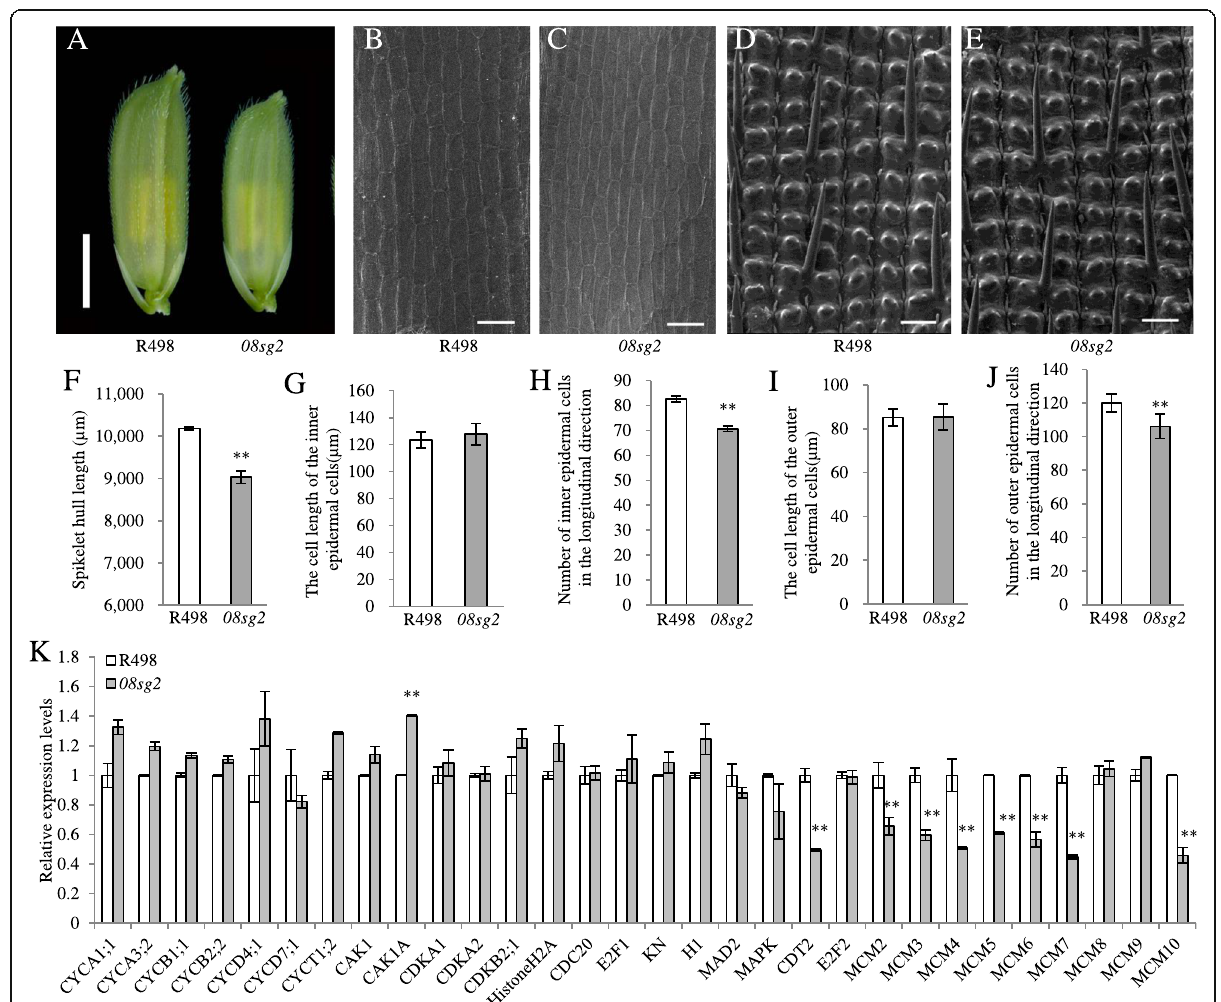
Fig. 2 08SG2 regulates grain length by changing cell division patterns. a The spikelet hulls of R498 and 08sg2 plants before anthesis. Scale bar, 3 mm. b , c Inner epidermal cells of the lemma observed by SEM. Scale bar, 100 μ m. d , e Outer epidermal cells of the lemma observed by SEM. Scale bar, 100 μ m. f Comparison of spikelet hull length between R498 and 08sg2 ( n = 10). g , h Comparison analysis of the cell length, cell number in the inner epidermal cells ( n = 30). i , j Comparison analysis of the cell length, cell number in the outer epidermal cells ( n = 30). k Transcript levels of the cell cycle-related genes in R498 and 08sg2 . The analysis of relative expression levels was determined by qRT-PCR using 5 – 7 cm young panicles . OsActin was used as the control and the values of expression levels in R498 were set to one ( n = 3). f - k , Data are given as means± SD. Student ’ s t-test was used to generate the P values; ** indicate P <